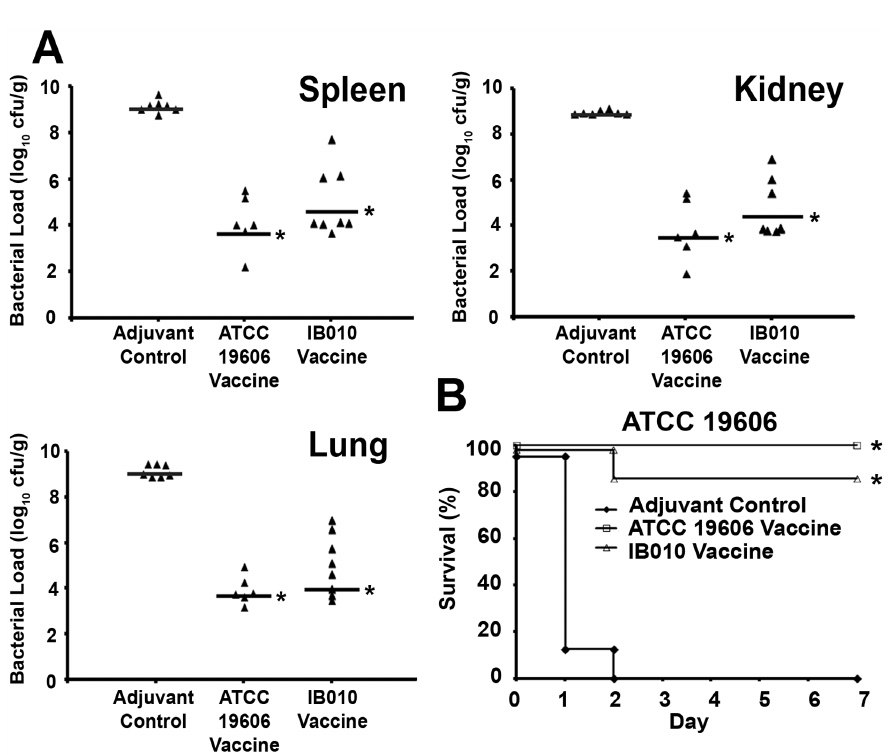
Figure 6. BALB/c bacterial loads and survival. Immunized and control mice were infected with 4.0 6 10 6 cfu (4.14 6 LD 50 ) of the ATCC 19606 strain. (A) Twelve hours post-infection spleen, kidney and lung bacterial loads were determined (n 5 8 mice/IB010 vaccine group; n 5 7 mice/control group; n 5 6 mice/ATC 19606 vaccine group). Data points represent bacterial loads from individual mice, and horizontal lines represent median values from groups of mice. * p , 0.05 compared to control mice. (B) Vaccinated and control mice were infected with 4.0 6 10 6 cfu (4.14 6 LD 50 ) of the ATCC 19606 strain and survival was monitored for seven days. (n 5 7 mice/IB010 vaccine group; n 5 8 mice/control group); n 5 8 mice/ATC 19606 vaccine group) * p , 0.05 compared to control